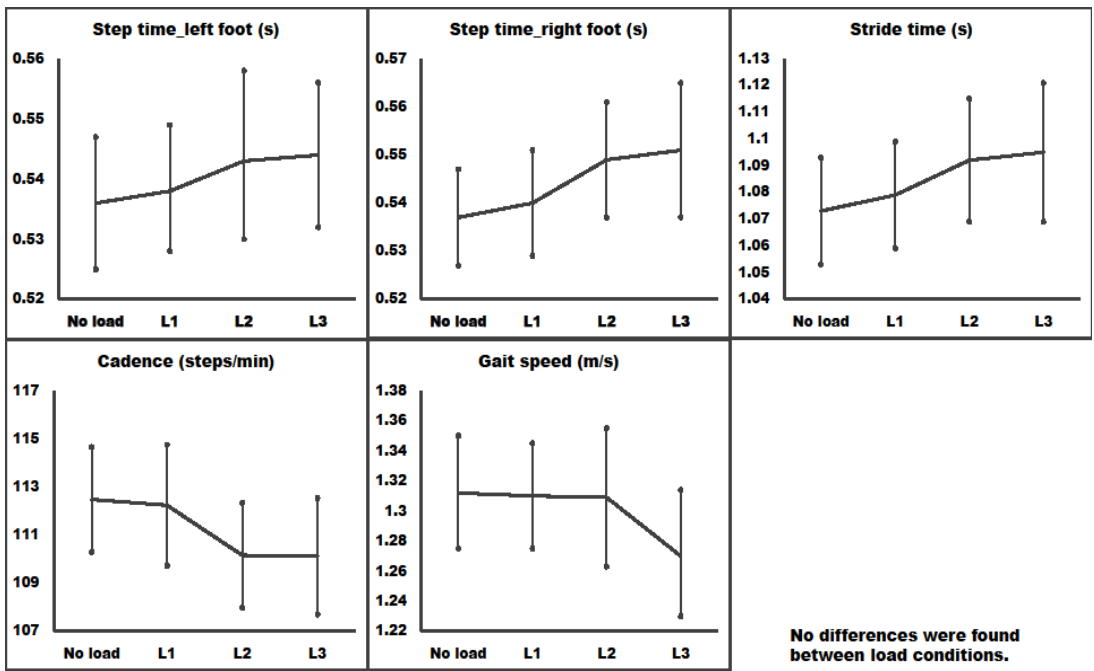
Figure 2. Changes in temporal parameters under different loading conditions of no load (only body weight), L1 (5 kg load), L2 (25 kg load) and L3 (45 kg load), (N = 30).